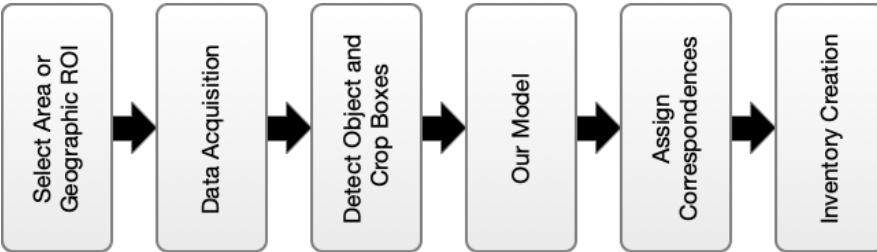
Figure 3. The overall pipeline which encompasses our proposed model. First, a geographic region of area is selected. Then, for that geographic region, the imagery and metadata pertaining to it are downloaded. An object detector detects the objects in this imagery. Our proposed model takes in pairs of image crops of the object and decides if they are matching or not. An inventory is created of the objects, with a pool of image crops from different views for each